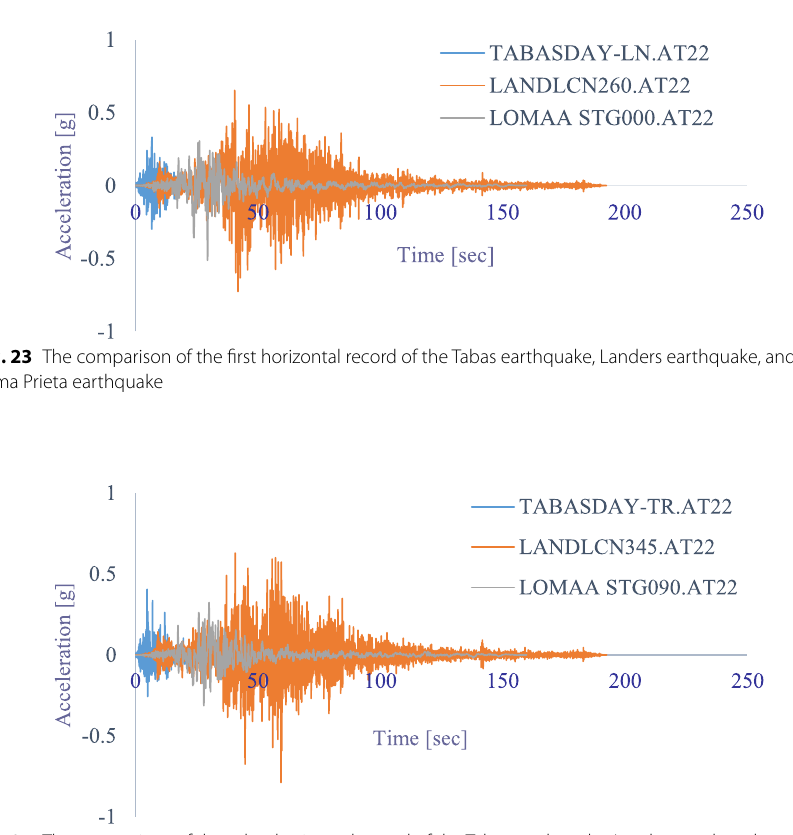
Fig. 24 The comparison of the other horizontal record of the Tabas earthquake, Landers earthquake, and Loma Prieta